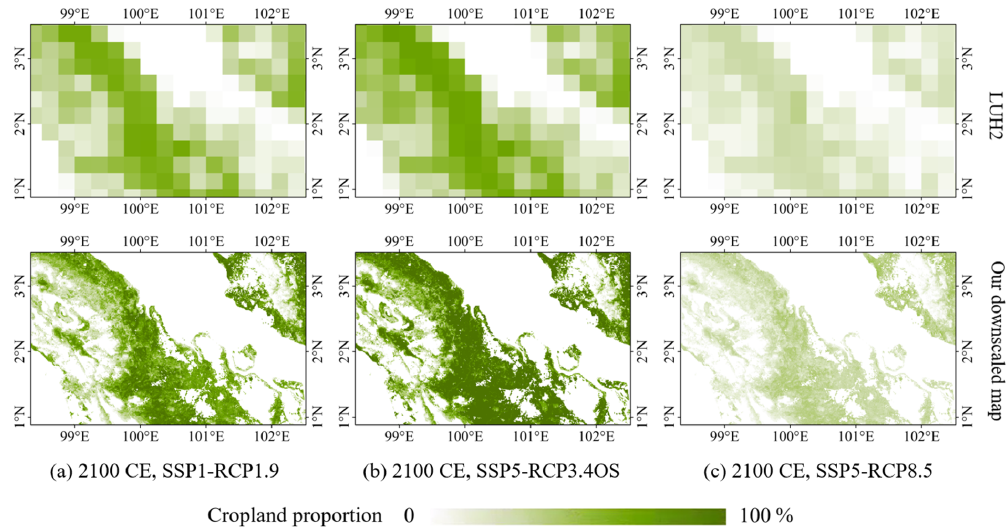
Figure 6. Cropland distribution of the region shown in Fig. 4f for different scenarios (a–c) . The location of image center points is Riau, Indonesia (2 . 199 ◦ N, 100 . 425 ◦